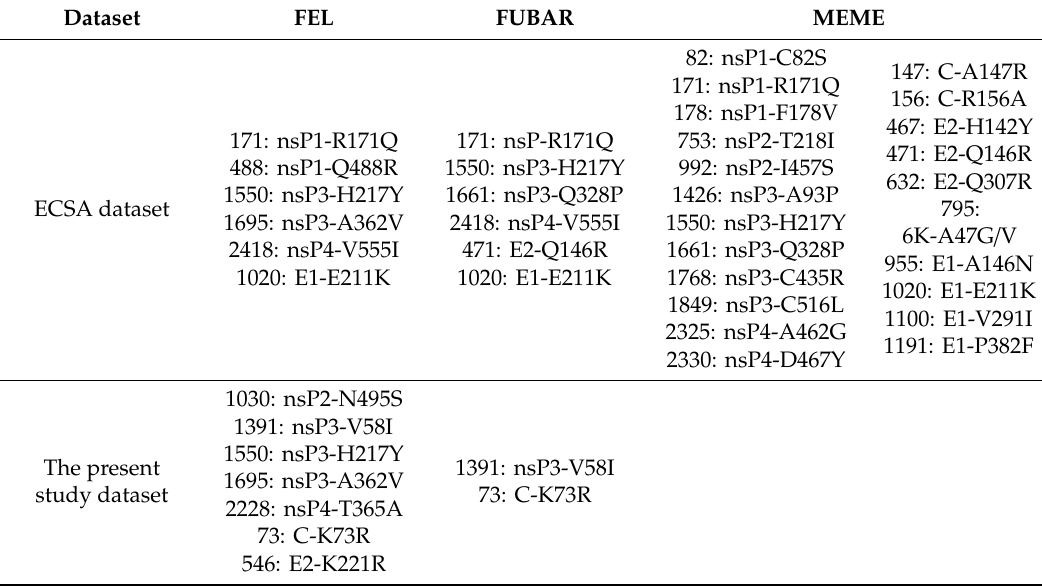
Table 4. Codon sites and amino acid substitutions under positive selection